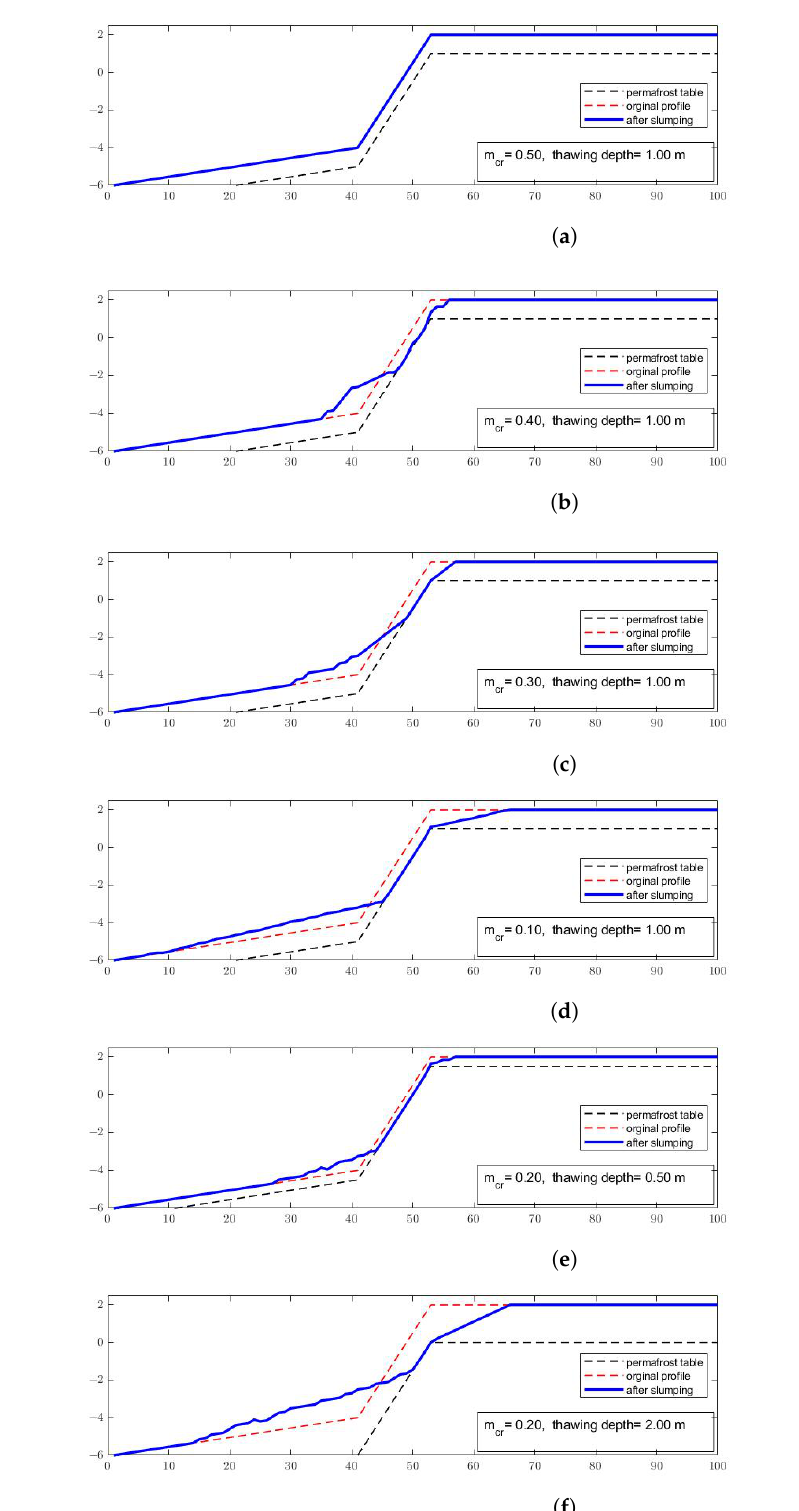
Figure A3. Application of the thawing module in some cases. ( a ) m cr = 0.5, initial slope = 0.5, thawing depth = 1 m; ( b ) m cr = 0.4, initial slope = 0.5, thawing depth = 1 m; ( c ) m cr = 0.3, initial slope = 0.5, thawing depth = 1 m; ( d ) m cr = 0.1, initial slope = 0.5, thawing depth = 1 m; ( e ) m cr = 0.2, initial slope = 0.5, thawing depth = 0.5 m; ( f ) m cr = 0.2, initial slope = 0.5, thawing depth = 2